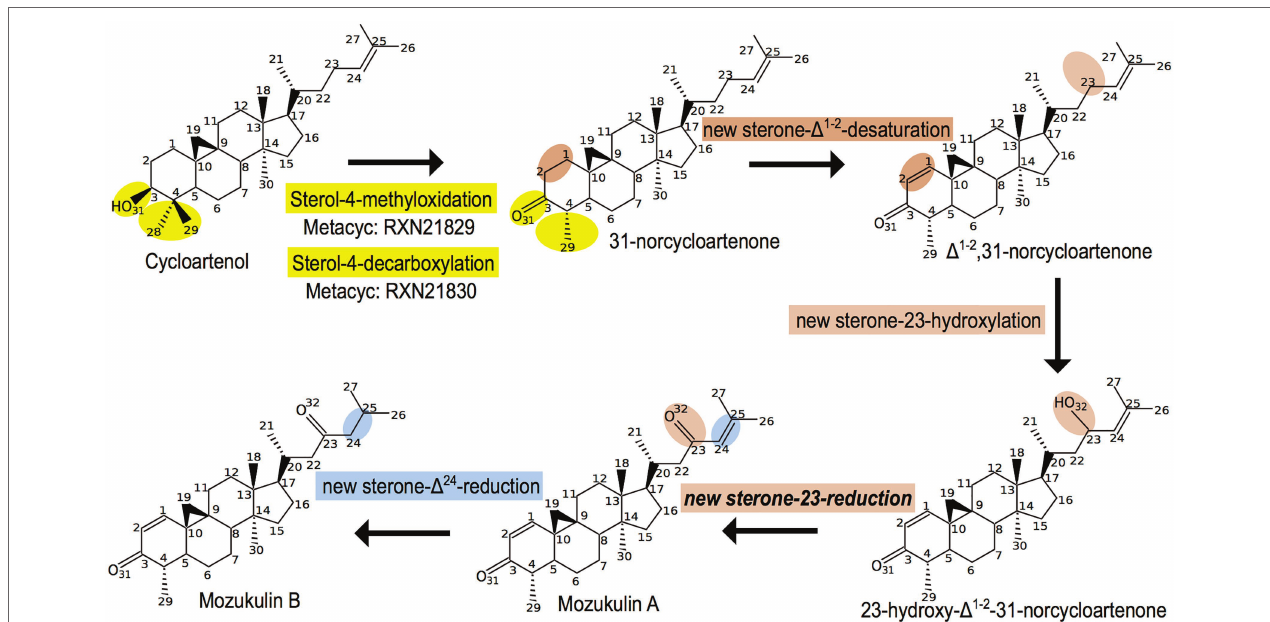
FIGURE 3 | Ab initio inference of the mozukulin pathway in the Ectocarpale alga Cladosiphon okamuranus . In yellow: reactions identical to the late sterol side-chain reductase (SSR) biosynthesis pathway. In blue: new variant from the Δ 24 -reduction, distinct from those present in the early or late sterol biosynthesis pathways. In brown: reactions variants coming either from other pathways (bacterial steroid degradation or brassinosteroid synthesis) or even more distant type of molecular transformation, previously defined as “type hIIc homologies” (Cunchillos and Lecointre,